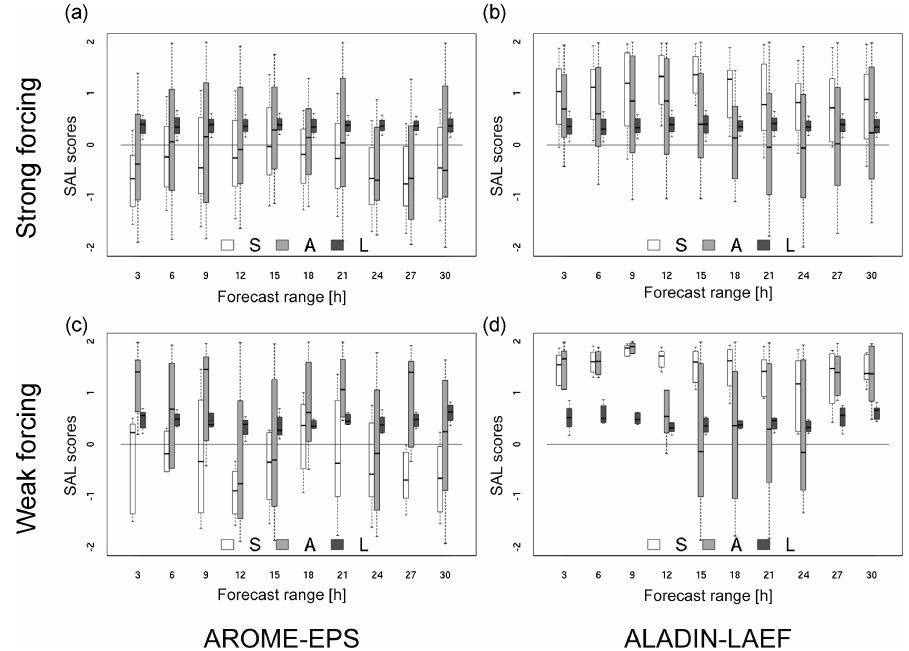
Figure 8. Same as in Fig. 7, but for region